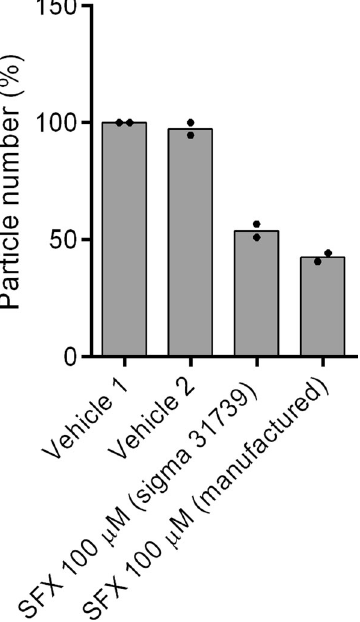
Fig. 1 sEV secretion from MDA-MB-231 cells with or without SFX 100 µ M (Sigma 31739, and manufactured SFX). All experiments were performed with a blind test ( n = 2 biologically independent